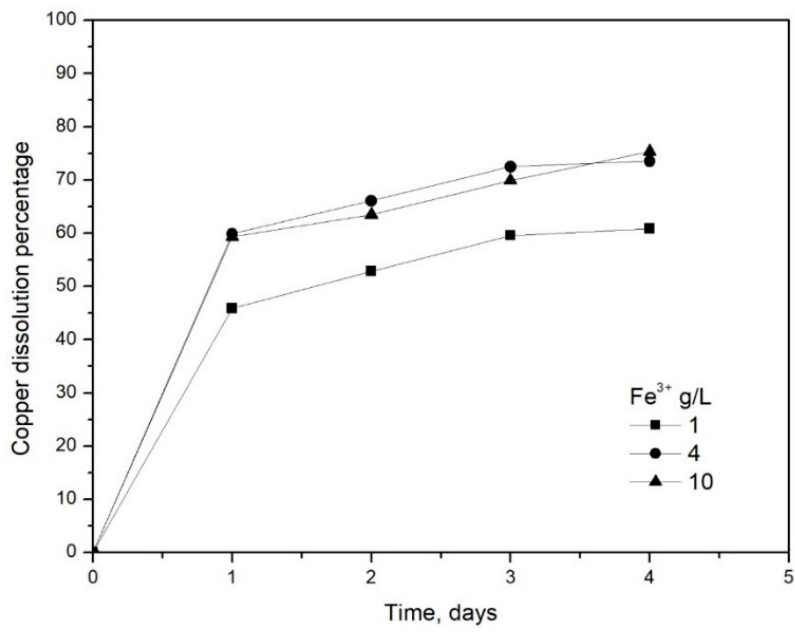
Figure 6. Copper recovery curves in leaching with a variation of Fe 3+ , 20 g/L H 2 SO 4 under conditions of 1 atm, 22 °C, and 400 rpm.